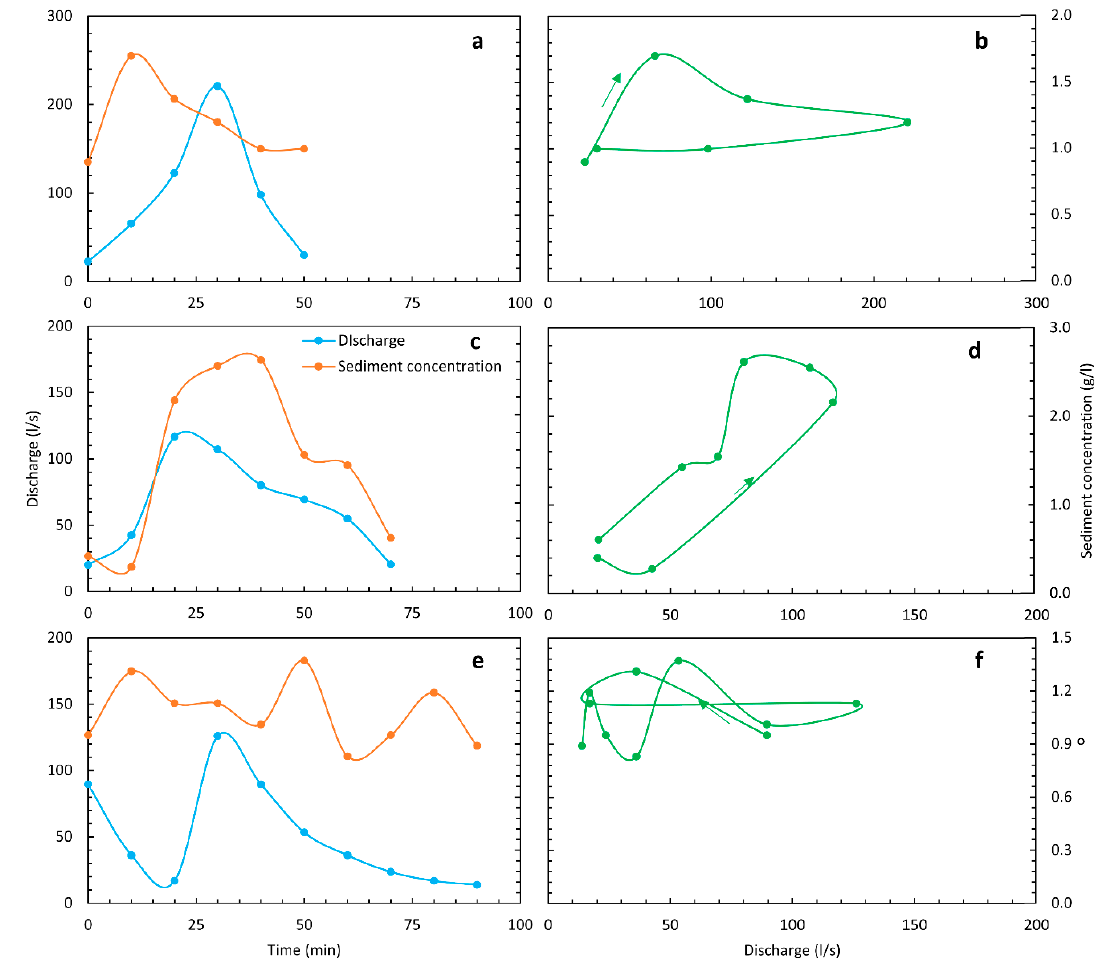
Figure 9. Representative examples of hydrographs and sedigraphs ( left ) and hysteresis loops ( right ) for the Debre Mawi watershed during the rainy season: ( a , b ), clockwise pattern at the outlet of the main watershed W5 on 27 August 2017; ( c , d ), counter-clockwise pattern at the outlet of the nested watershed W1 on 1 August 2012; and ( e , f ), mixed loop pattern, watershed W2 on 6 July 2016.